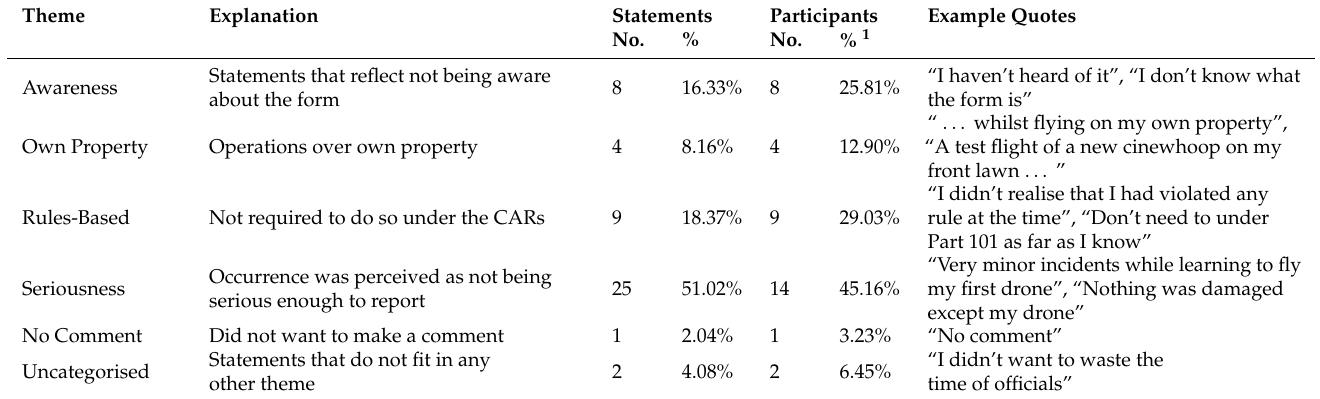
Table 5. Reasons for not using CA005RPAS forms to report any occurrences.